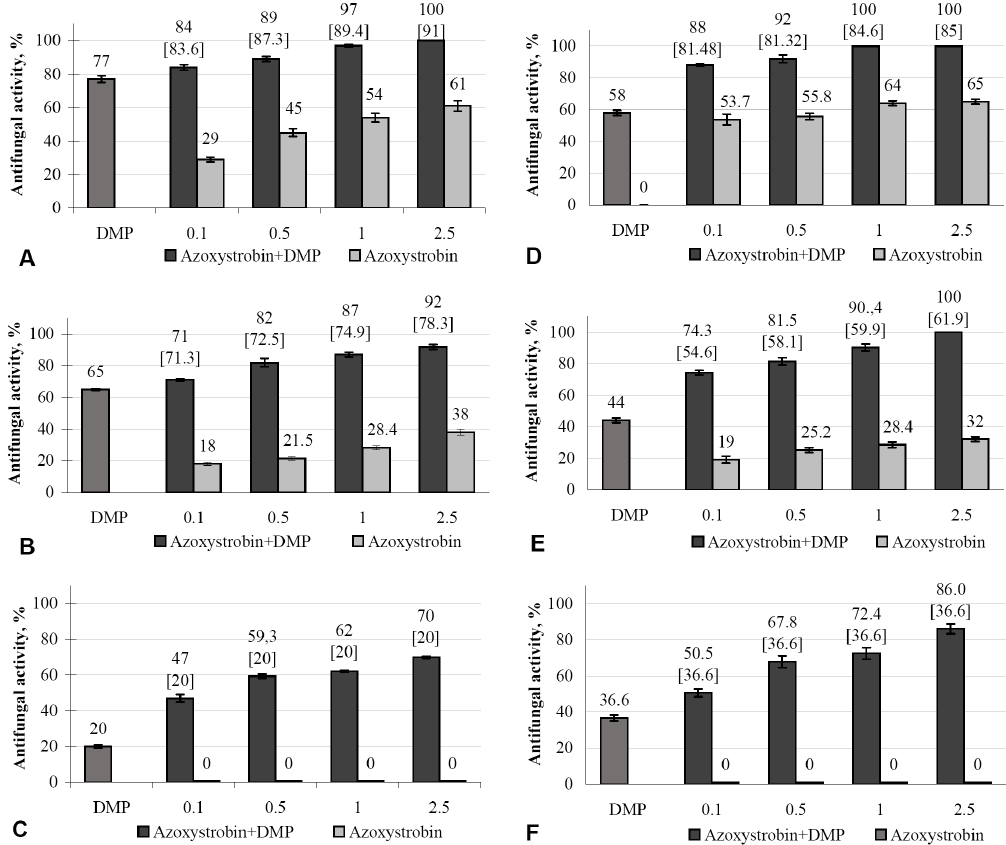
Figure 7. Antifungal activity of the DMP (5 g/L) and azoxystrobin (0–2.5 mg/L) combinations towards Fusarium oxysporum MP-14-6 (left, A – C ) and F. culmorum BP-03-19 (right, D – F ). Regular numbers indicate the experimental values of antifungal activity ( E R , p ≤ 0.05) and numbers in brackets correspond to the expected E E value ( p ≤ 0.05) calculated according to [28]. The data were obtained after 3 ( A , D ), 7 ( D , E ) and 14 ( C , F ) days of incubation.